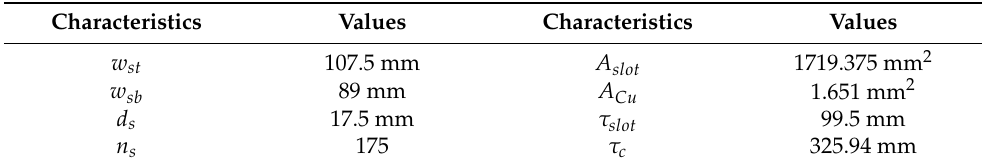
Table 9. Characteristics of the optimized stator core using GA.